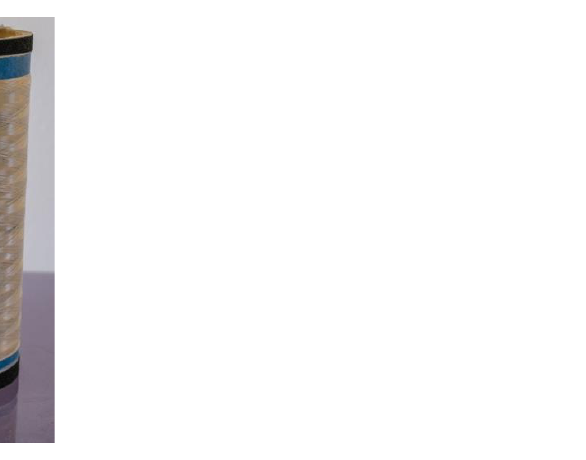
Figure 2. Photograph of bobbins with precursors spun from dopes containing 30 wt% lignin and 70 wt% cellulose ( left ) or 100 wt% cellulose ( right ).